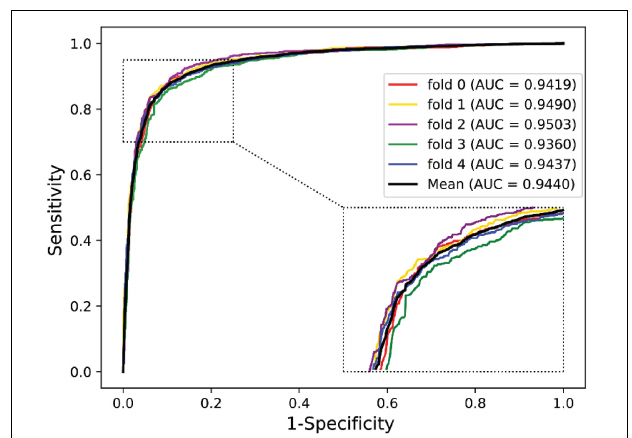
FIGURE 4 | The ROC curves of our approach on the Oryza sativa dataset under five-fold CV.